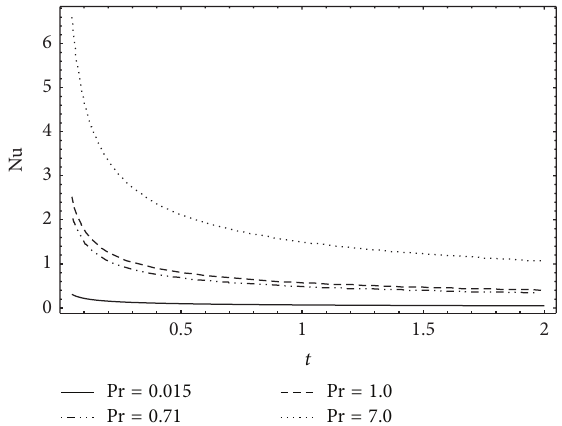
Figure 13: Variations of Nusselt number Nu along 𝑡 for different values of Pr corresponding to stepped temperature of the